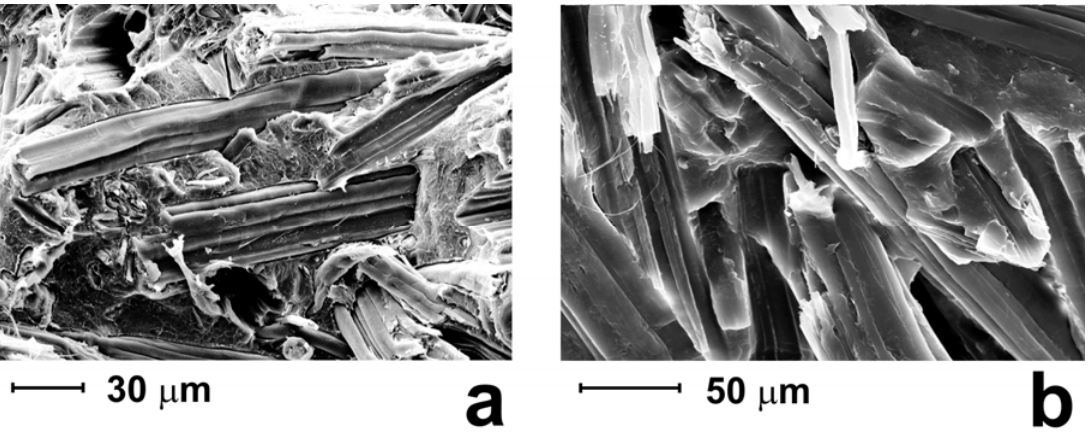
Figure 1. SEM micrographs of PLA/kenaf composites containing 30 wt% of kenaf fibres: (a) uncompatibilized materials; (b) compatibilized